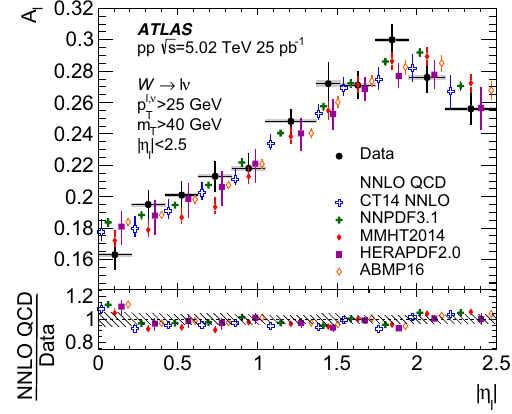
Fig. 13 Charge asymmetry for W bosons as a function of absolute decay lepton pseudorapidity compared with theoretical predictions. Statistical and systematic errors are shown as corresponding bars and shaded bands on the data points. Only the dominant uncertainty (PDF) is displayed for the theory. The lower panel shows the ratio of pre- dictions to the measured differential cross section in each bin, and the shaded band shows the sum in quadrature of statistical and systematic uncertainties of the